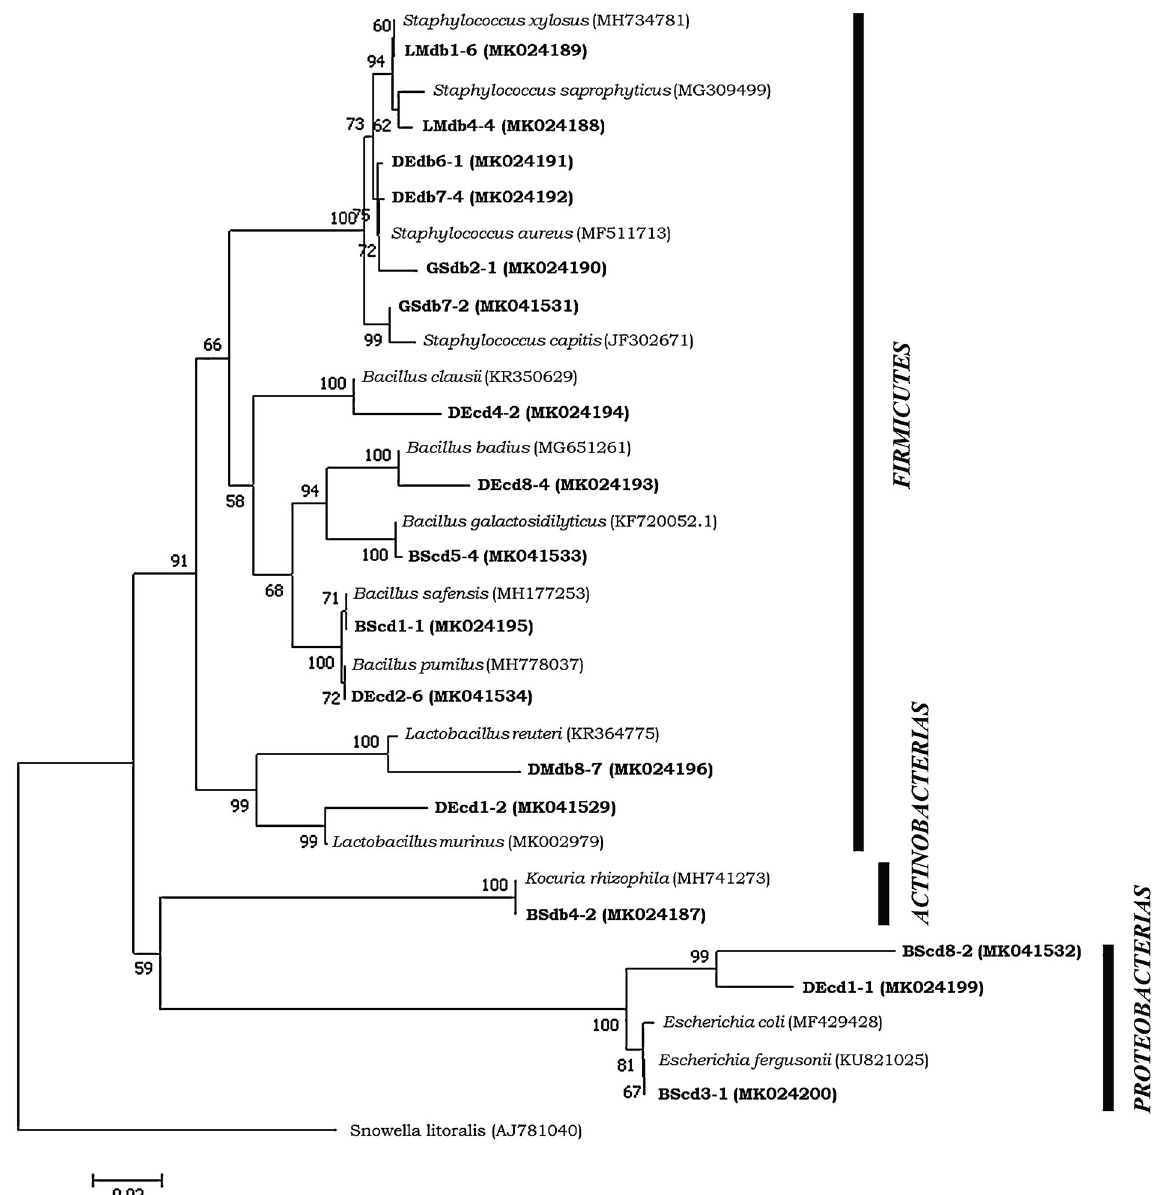
Figure 3: Dendrogram of 9 groups with their respective enzyme restriction pro fi les. Phylogenetic tree neighbor joining based on sequences of 16S rRNA that shows the phylogenetic relationships of the Firmicutes phylum species, Proteobacteria and Actinobacteria . The Boostrap value of 1000 repetitions is used. The GenBank accession numbers of the 16S rRNA sequences are shown in parentheses. Scale bar corresponds to 20 substitutions for nucleotide positions. The 16S rRNA sequence of the Cyanobacterium member was used as an external group (accession number: